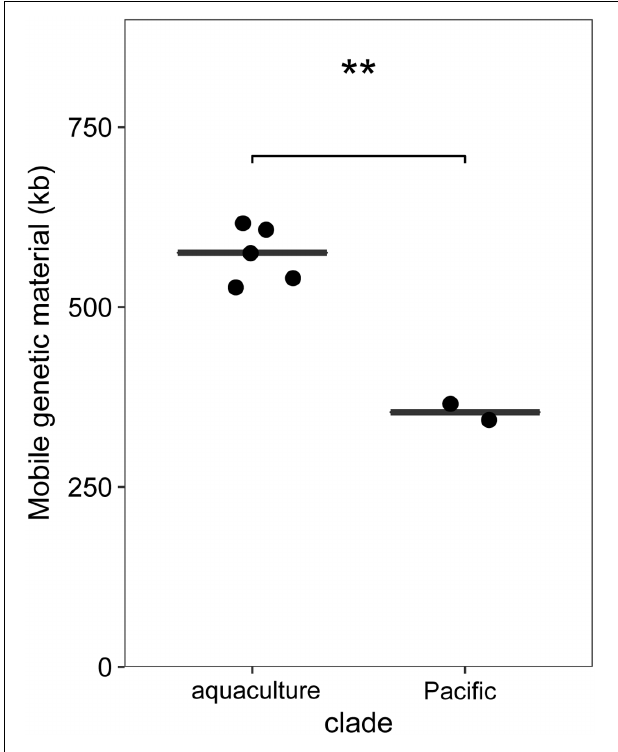
FIGURE 5 | Differences in the summed sequences of mobile elements (plasmids, phages, genomic islands) between P. gallaeciensis clades. Horizontal lines show median and ∗∗ denotes t -test with p <